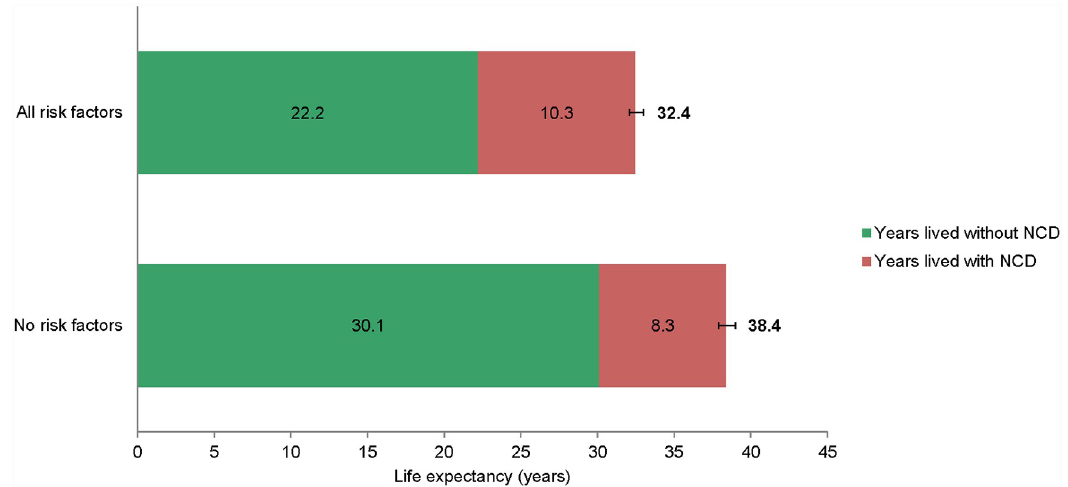
Fig 5. Remaining life expectancy at age 45 years with and without NCD stratified by risk factor burden. Participants aged 45 years and older without the 3 risk factors of smoking, hypertension, and overweight at baseline spent 21.6% (8.3 years divided by 38.4 years) of their remaining lifetime with at least 1 NCD, which was a substantially lower proportion compared to the 31.8% (10.3 years divided by 32.4 years) for those with all 3 of these risk factors at baseline. Error bars represent 95% confidence intervals. NCD, non-communicable